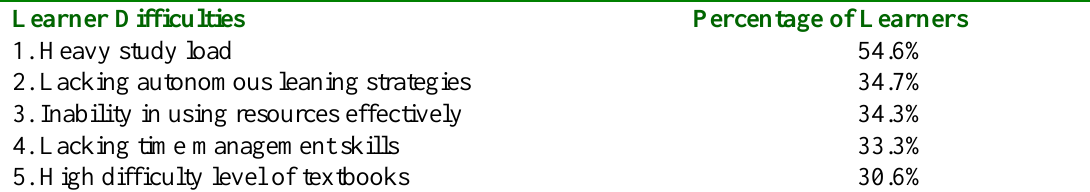
Table 9. Perceived difficulties by learners in the learning process Learner